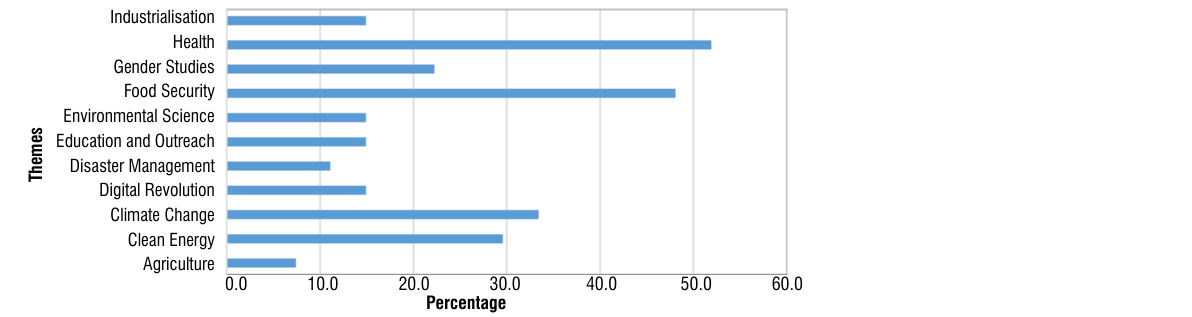
Commentary https://doi.org/10.17159/sajs.2019/5876